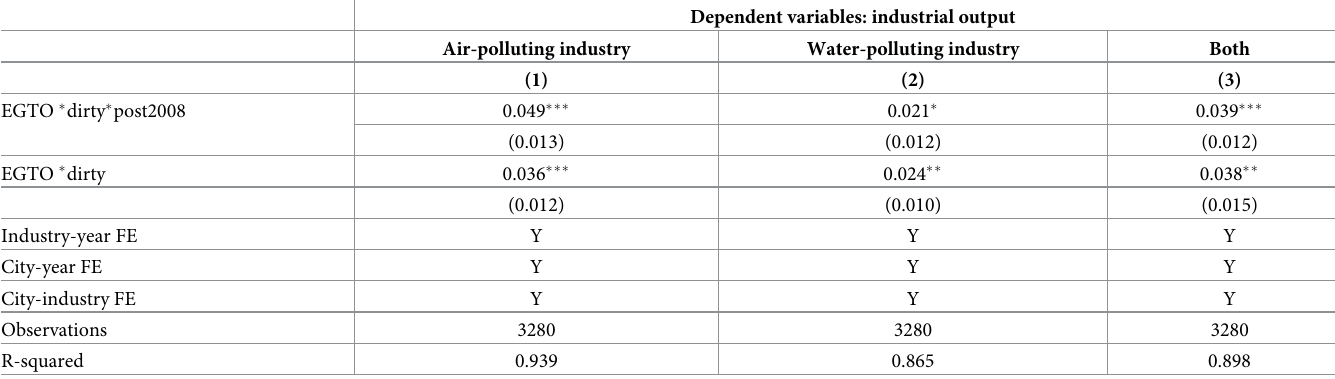
Table 9. Effect of the 2008 global financial crisis on the impact of